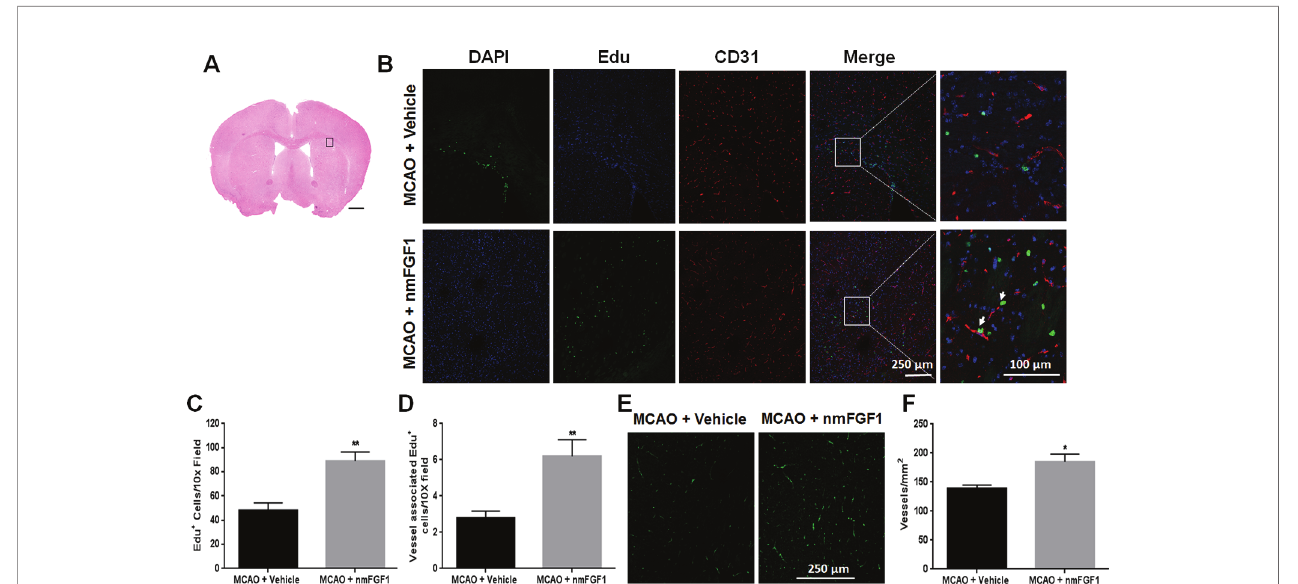
FIGURE 2 | Non-mitogenic fi broblast growth factor 1 (nmFGF1) promoted angiogenesis in ischemic boundary following ischemia stroke. (A) A representative image of hematoxylin-eosin (HE) staining in a coronal brain section at 10 days after middle cerebral artery occlusion (MCAO). Box illustrates the peri-infarct areas from the corpus callosum where images in B were taken. (B) Representative immuno fl uorescence images of DAPI and EdU staining along with the staining for the vascular endothelium marker CD31 at 10 days after stroke. (C) Quantitative analysis of EdU- labeled cells in ischemic boundary following stroke. (D) Quantitative analysis of EdU + /CD31 + co-labeled cells in ischemic boundary following stroke. (E) Representative fl uorescence image for vascular density analysis following staining with CD31 at 10 days after stroke. (F) Quantitative analysis of vascular density by CD31 labeling. Data are expressed as means ± SEM (n = 5). *p < 0.05 and **p < 0.01 as compared with the MCAO + vehicle